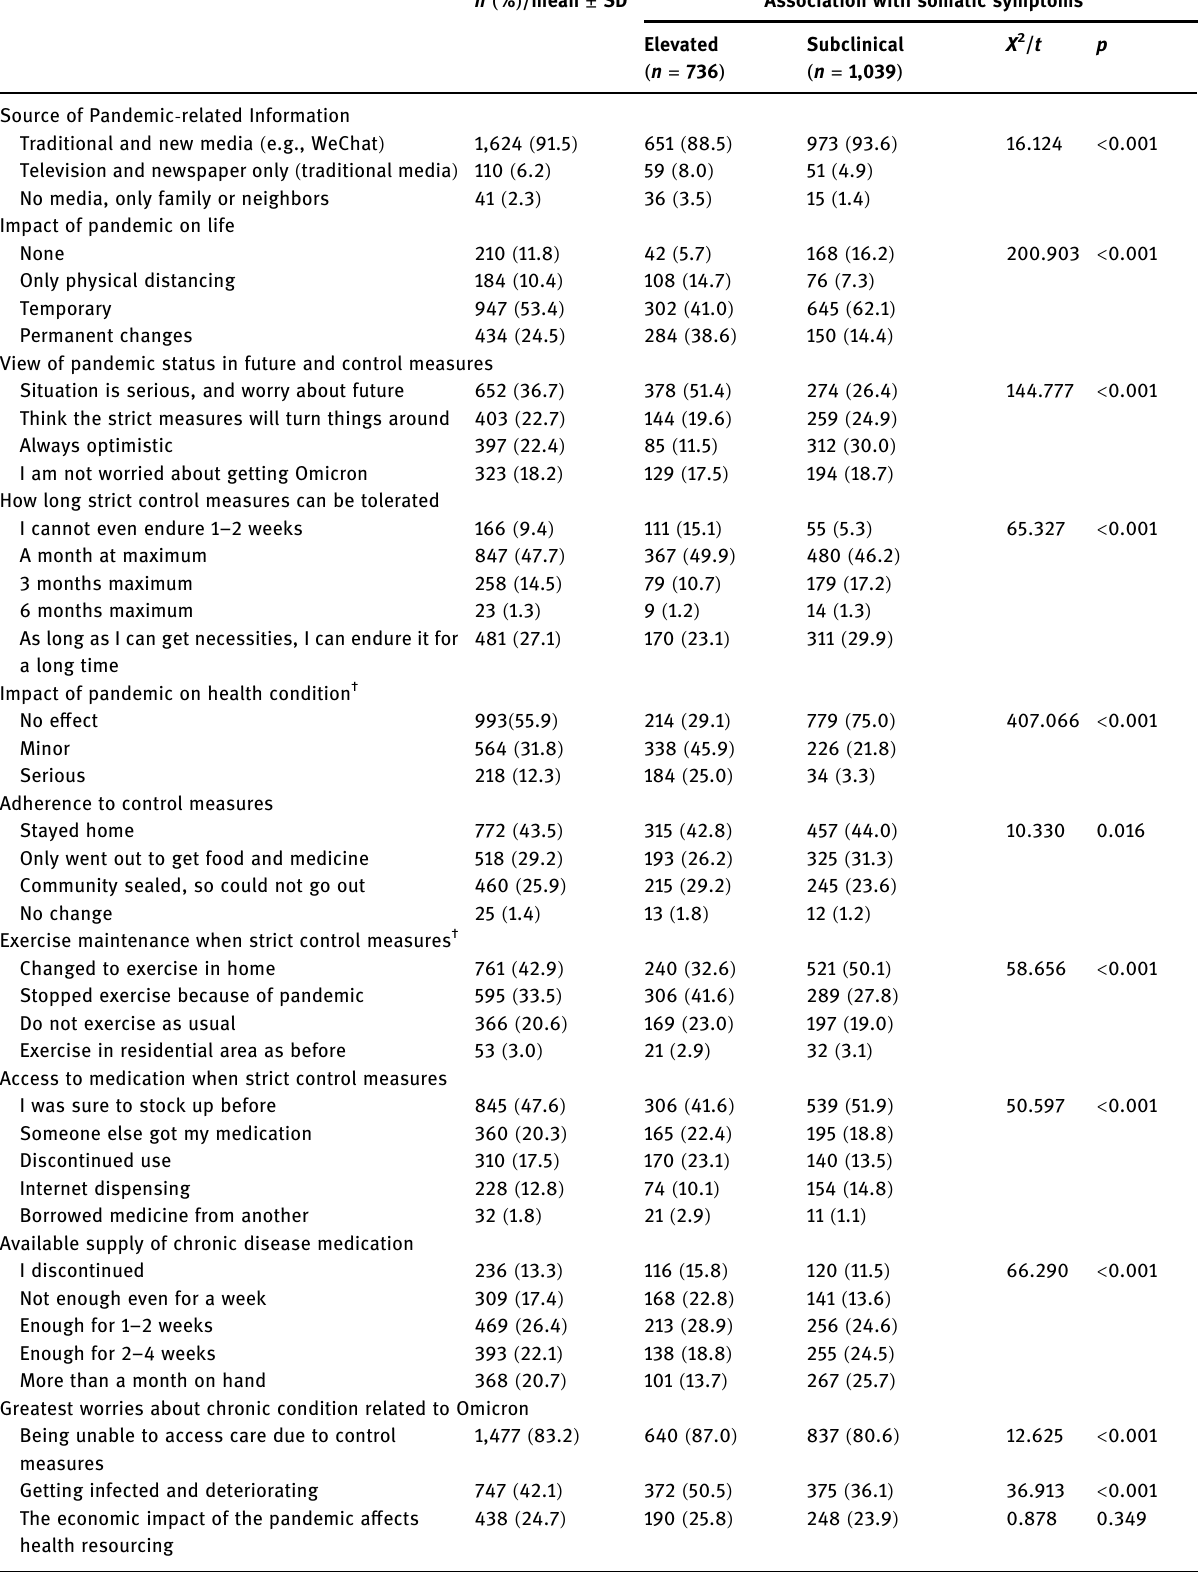
Table 3: Participant pandemic attitudes and impact on chronic disease management ( N = 1,775